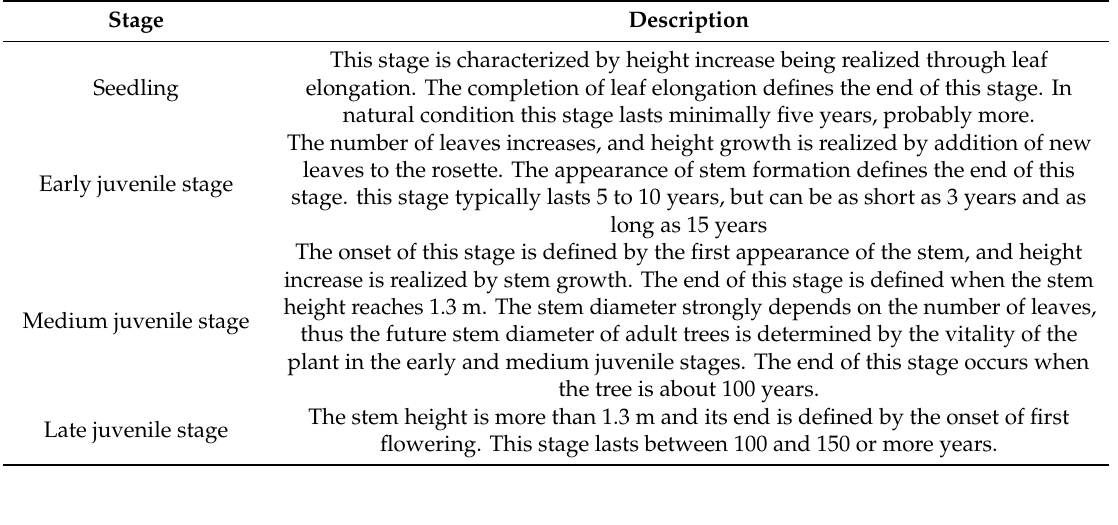
Table 1. Description of juvenile stages of D. cinnabari (according to Madˇera et al., [113]).